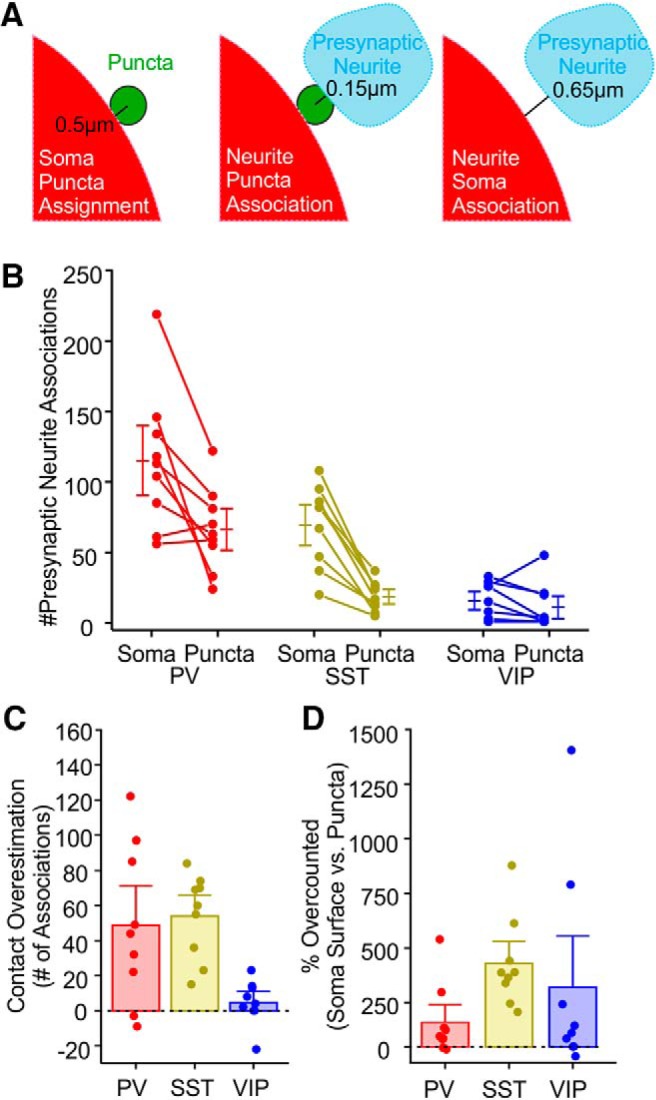
FAPpost detection improves estimates of input association. A, Diagram illustrating distance parameters used for FAPpost puncta assignment to soma-surface (left), soma-puncta association with presynaptic YFP-expressing neurites (middle), and presynaptic neurite associations with soma-surface (right). B, Comparison of the number of presynaptic neurite to soma-surface and soma-puncta associations. Connected lines = individual cell values. More PV neurite to PYR soma-surface (115 ± 16) than soma-puncta contacts were detected (66 ± 30; paired t test, t = 3.3, p = 0.01). More SST neurite to soma-surface (69 ± 10) than soma-puncta contacts were detected (15 ± 8; paired t test, t = 6.7, p = 0.0001). Number of VIP neurite to soma-surface (16 ± 4) and soma-puncta contacts were similar (11 ± 5; paired t test, t = 1.1, p = 0.3). C, Contact overestimation depicts the difference between presynaptic neurite to soma-surface and soma-puncta associations for presynaptic PV neurites (+49 ± 15), SST neurites (+54 ± 8), and VIP neurites (+5 ± 4). Negative values occurred when multiple puncta were associated with a single presynaptic terminal. D, Error rate for presynaptic neurite-to-soma associations versus soma puncta associations for PV (115 ± 56%), SST (394 ± 70%), and VIP inputs (280 ± 162%). Across PYR cells, the percentage overestimation did not vary by input cell type (ANOVACellType: F(2,24) = 1.7, p = 0.2). PV input: n = 9 cells, N = 4 animals; SST input: n = 9 cells, N = 4 animals; and VIP input: n = 9 cells, N = 3 animals.